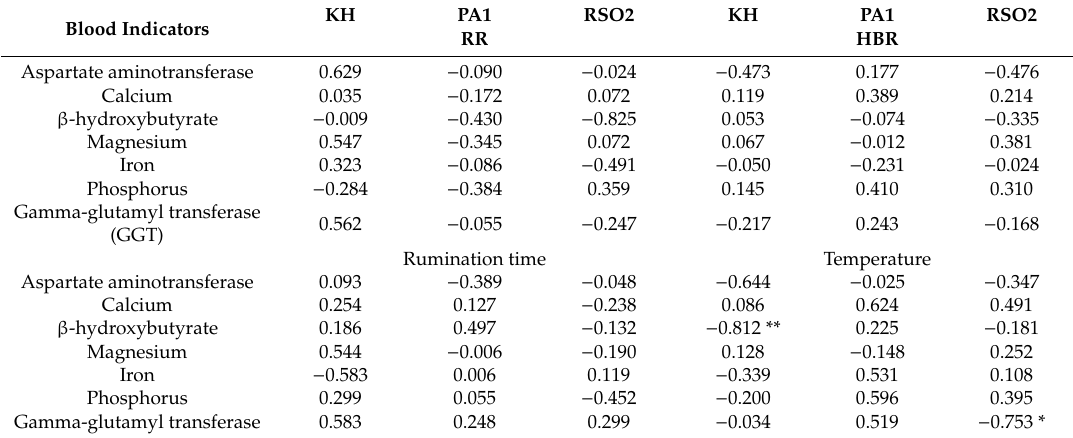
blood indicators for each group of